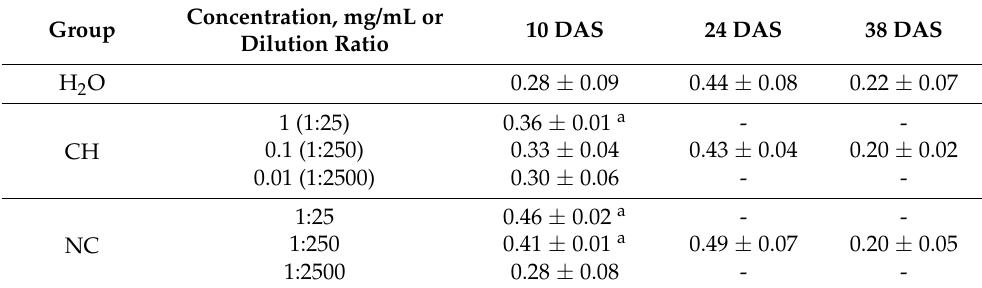
Table 2. Effect of CH, NC, and H 2 O on root